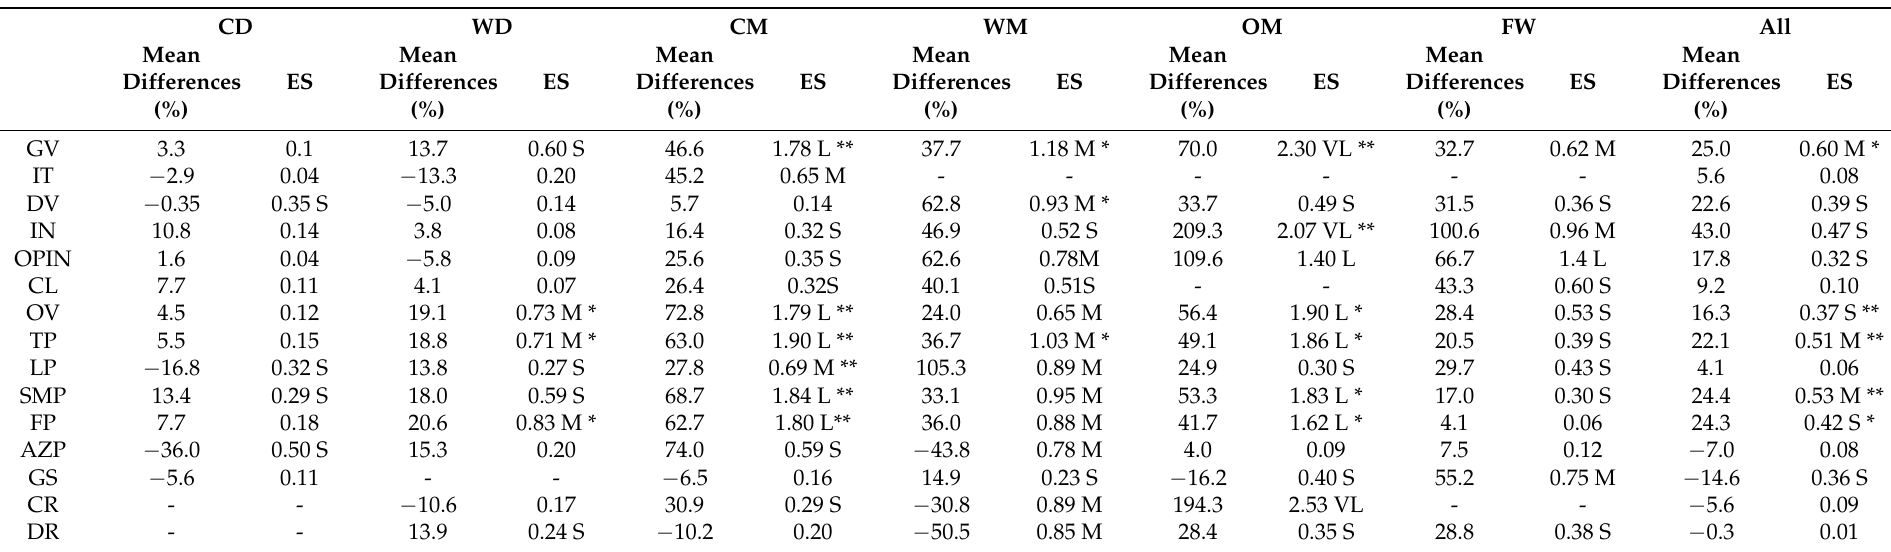
Table 5. Mean differences (%) and effect sizes (ES; ± CL) of the technical-tactical actions encountered by soccer players for each playing position and for all players between the 1-4-2-3-1 and 1-4-4-2 diamond playing